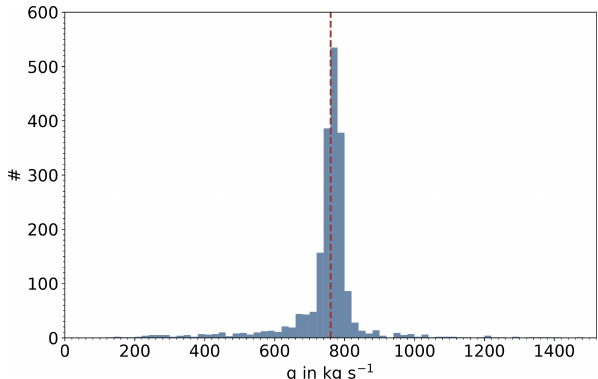
Figure 7. Histogram of virtually retrieved emission rates. The his- togram shows a slightly skewed distribution towards smaller emis- sion rates than the input emission rate (dashed red line). It depicts all 1980 emission rates retrieved over 66 simulated hours between 12:00UTC on 21 May and 06:00UTC on 24